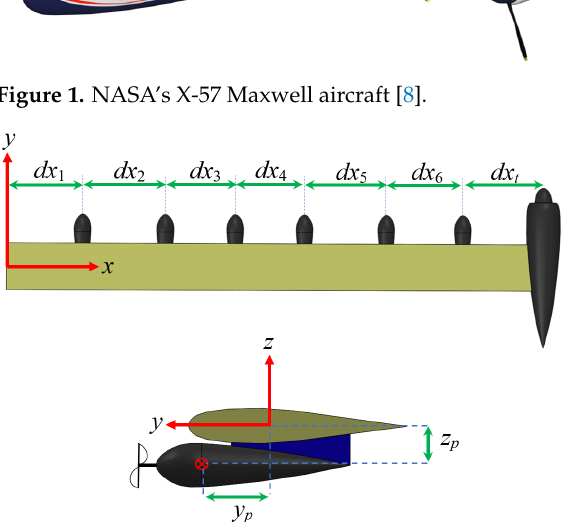
Figure 2. Schematic of the distributed electric propulsion (DEP) wing of the